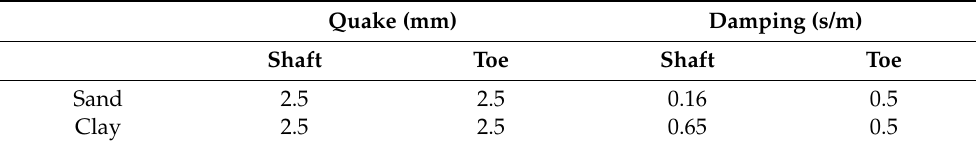
Table 2. Quake and damping